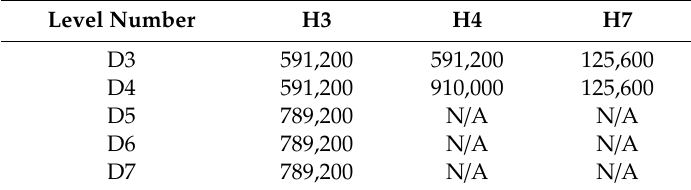
Table 4. Threshold activation versus number of loads.